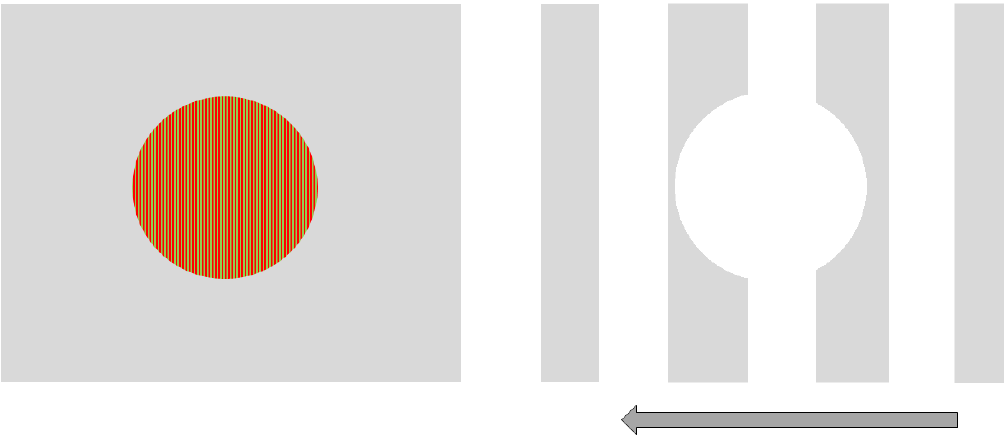
Figure 1. Parvocellular (PC)-biased ( left ) and magnocellular (MC)-biased ( right ) stimuli used in the